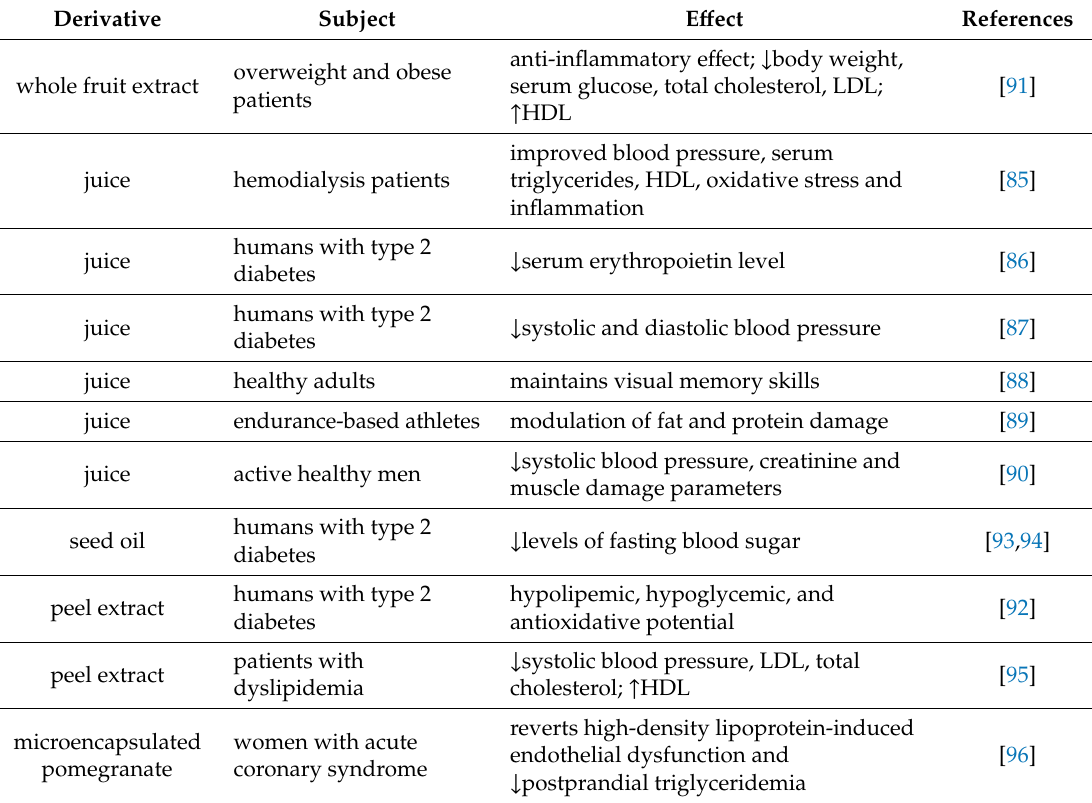
Table 5. Recent health-related pomegranate studies in